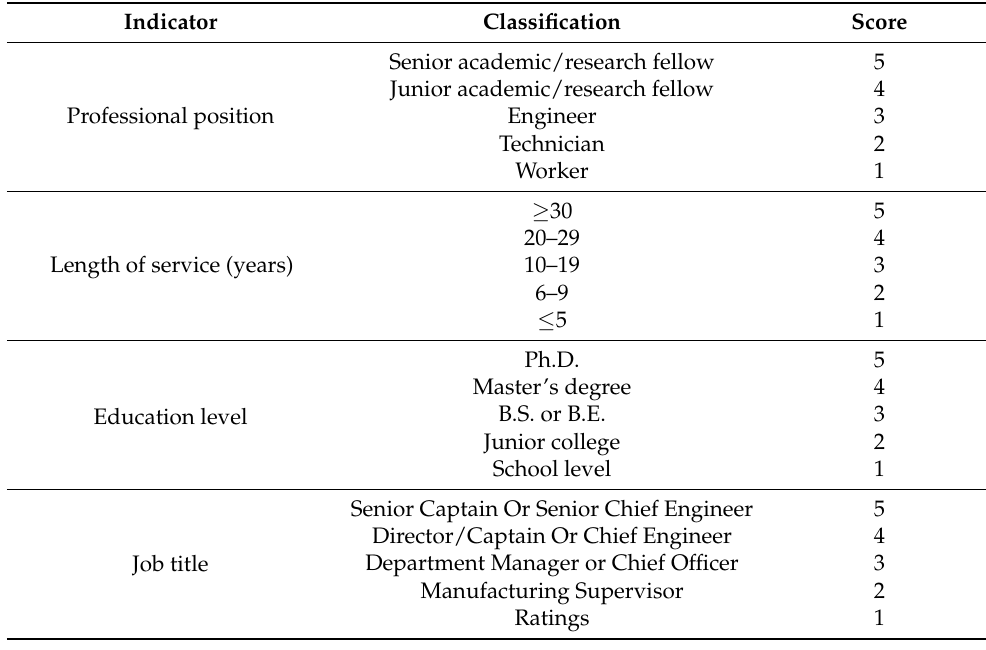
Table 3. Criteria for calculating expert